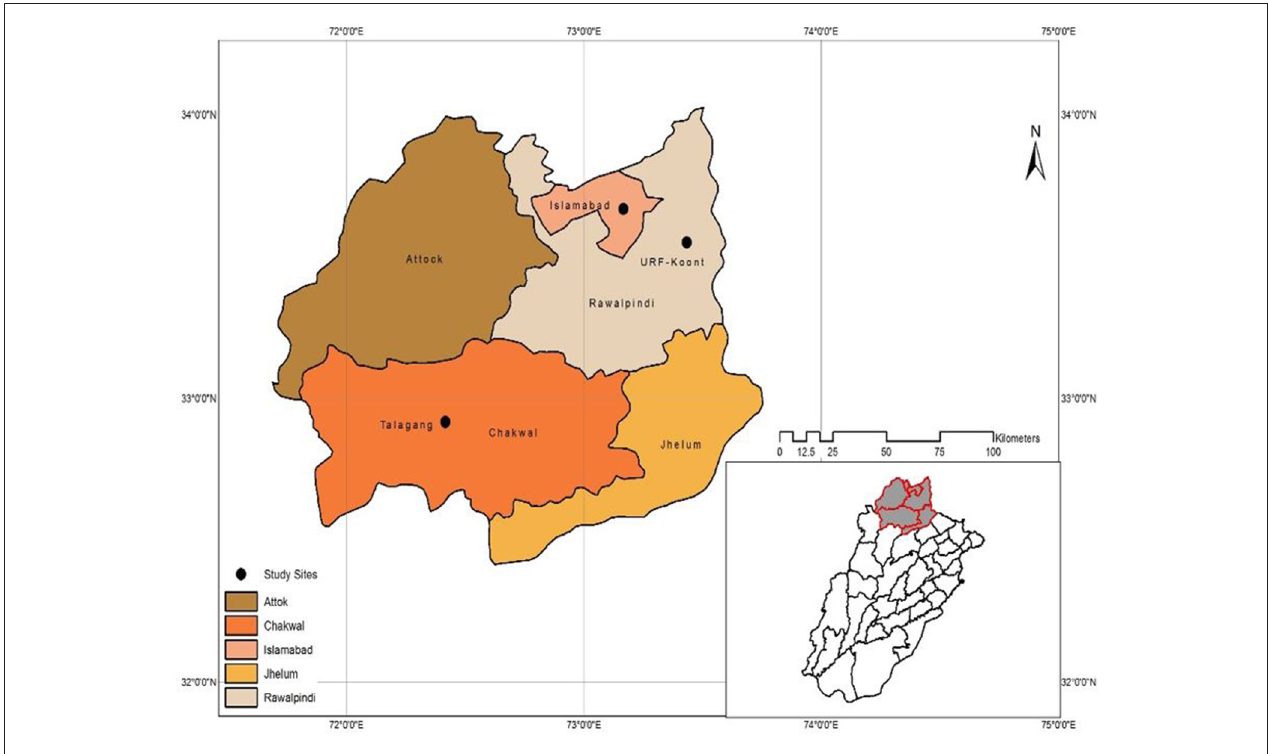
FIGURE 1 | Experimental study sites.